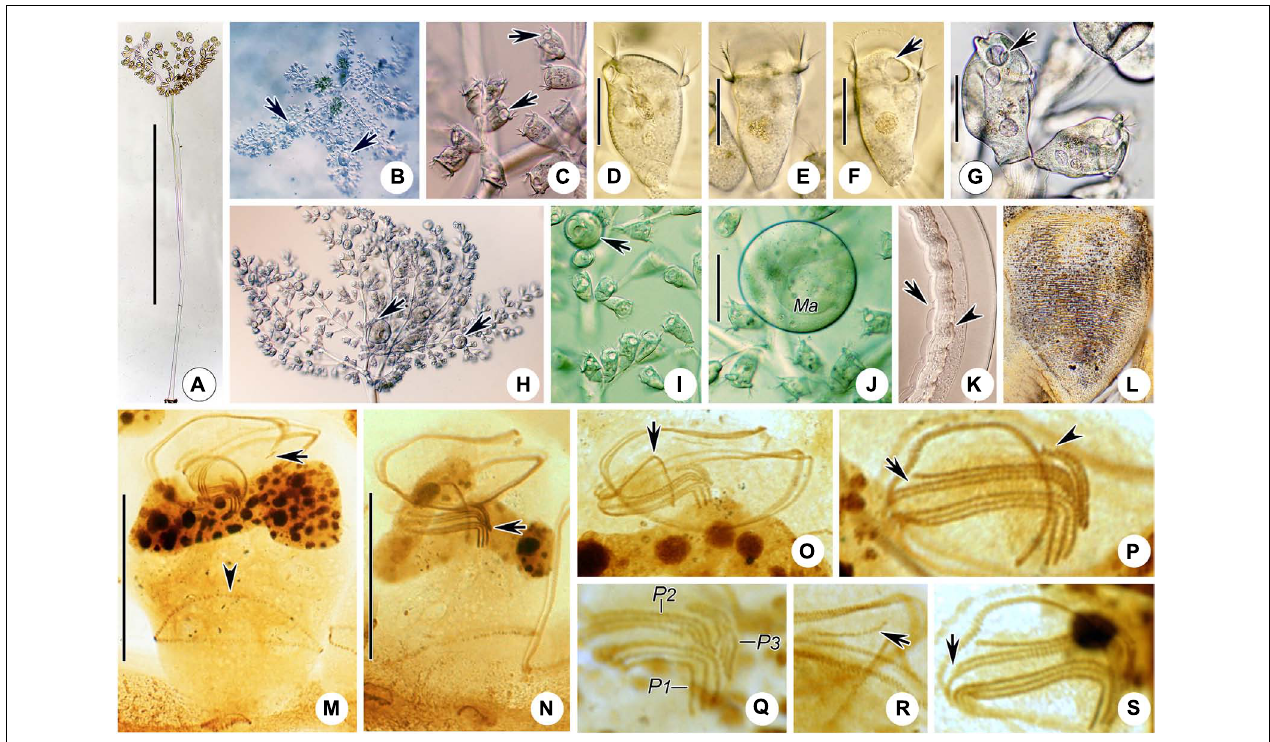
FIGURE 3 | Photomicrographs of Zoothamnium arbuscula in vivo (A–K) , after “dry” silver nitrate staining (L) , and after protargol staining (M–S) . (A) A developing colony. (B) Apical view of a mature colony; arrows mark the macrozooids. (C–I) Different zooids showing the shape variation; arrows in panels (C,F,G) mark the contractile vacuole, and arrows in panels (H,I) mark the macrozooids. (J) Macrozooid showing the macronucleus. (K) Detail of the stalk; arrow marks the folds on the surface, and arrowhead marks the spasmoneme. (L) Silverline system. (M,N) Two protargol-stained zooids showing the infraciliature and macronucleus; arrow in panel (M) marks epistomial membrane 2, arrowhead in panel (M) marks the trochal band, and arrow in panel (N) marks the infundibular polykineties. (O) Oral ciliature; arrow marks the germinal kinety. (P,Q) Infundibular polykineties 1–3 (P1–3); arrow in panel (P) marks the abstomal end of P2, and arrowhead in panel (P) marks the abstomal end of P3. (R,S) Part of the oral ciliature; arrow in panel (R) marks epistomial membrane 1, and arrow in panel (S) marks the abstomal end of P2. Bars: 900 µ m in panel (A) , 35 µ m in panels (D–G) , 100 µ m in panel (J) , and 25 µ m in panels (M,N)